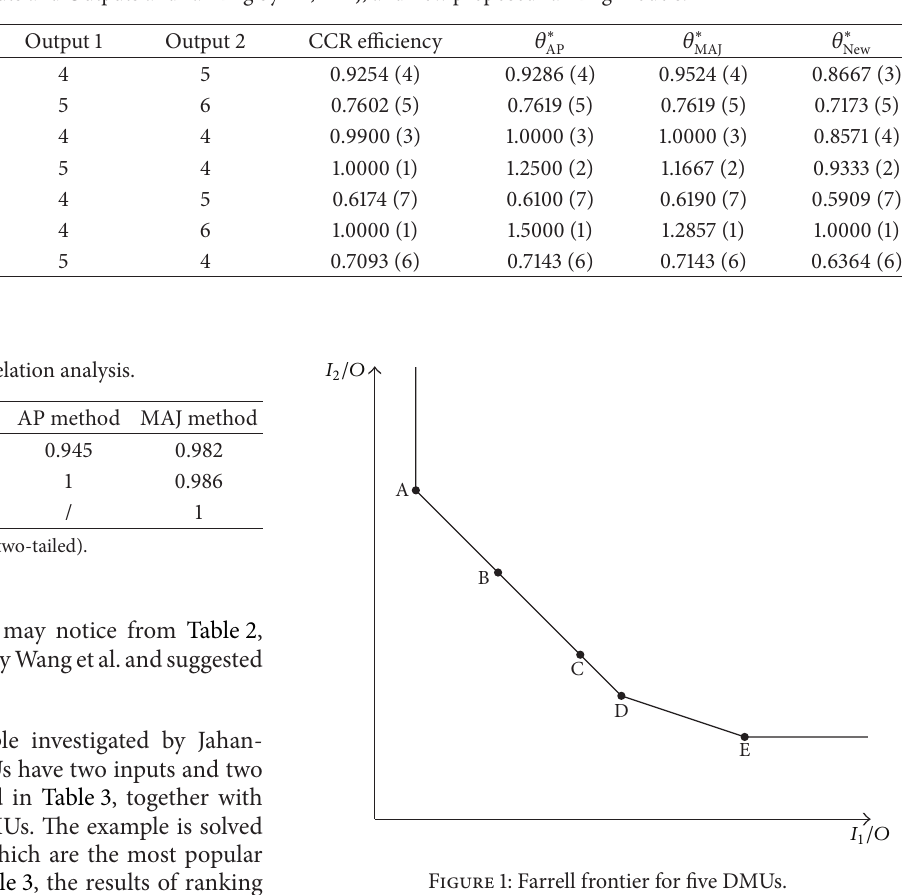
Table 3: Inputs and Outputs and ranking by AP, MAJ, and new proposed ranking models.